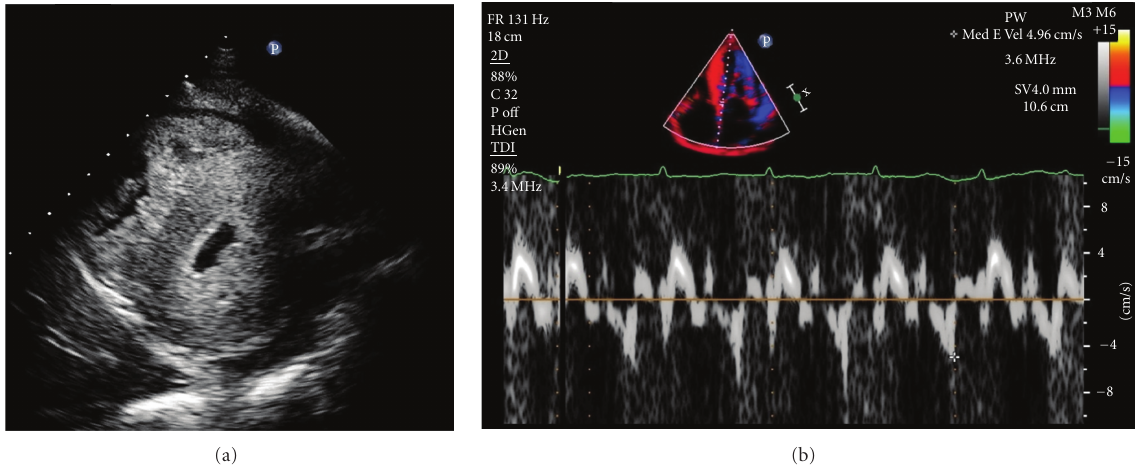
Figure 2: Transthoracic echocardiography in short-axis view (a) demonstrating severe concentric left ventricular wall thickening with “sparkling” appearance in a patient with cardiac amyloidosis. Tissue Doppler imaging (b) illustrating reduced systolic and early diastolic velocities at septal mitral annulus in a patient with cardiac